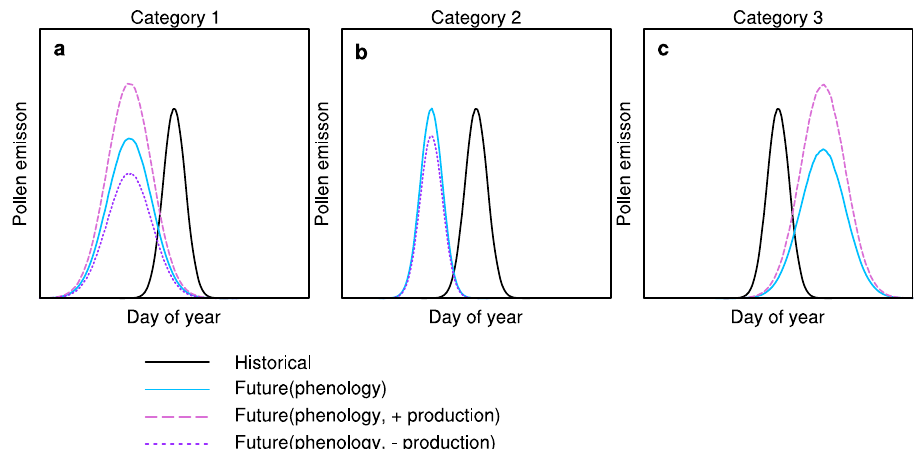
Fig. 2 Three categories of pollen emission changes. a – c Conceptual schematic for three categories of pollen emission changes, comparing the historical (black) and future (colors) daily pollen emission. Blues lines indicate the future pollen emission change with only temperature-dependent phenology. Pink and purple curves represent future pollen emission change with phenology change and temperature-dependent changes in the annual production factor (pf annual ), which can increase (pink) or decrease (purple)